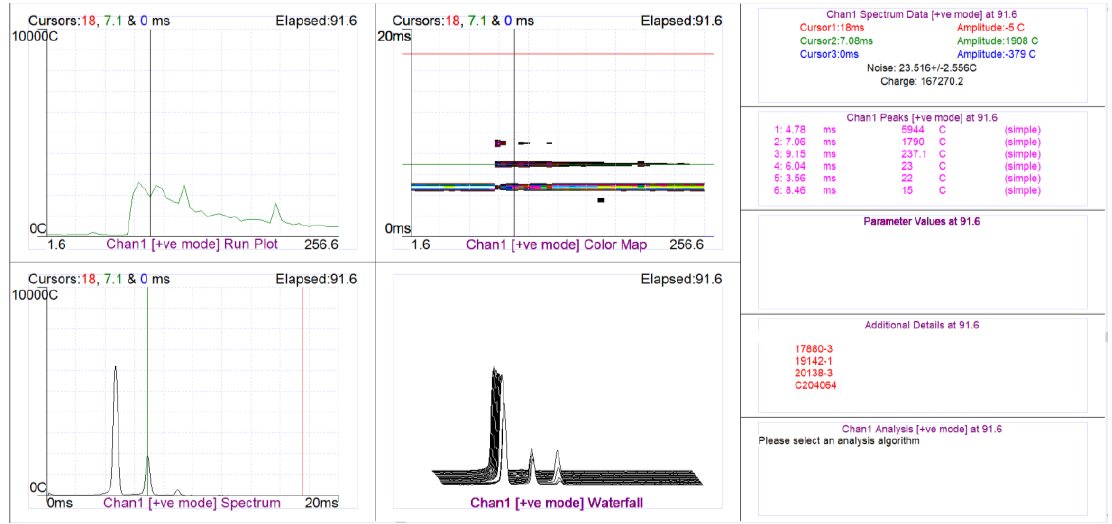
Figure 8. LCD3.3 trimscan reading of the alarm noticed in the field.